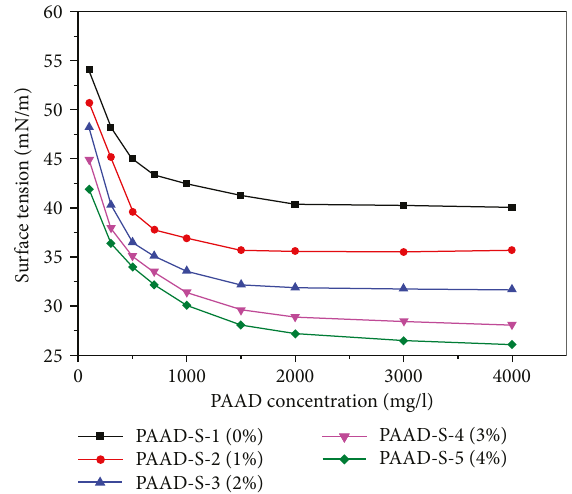
Figure 8: Variation of the surface tension with concentration of PAAD in water with the NaCl concentration of 1000mg/l at 25 °